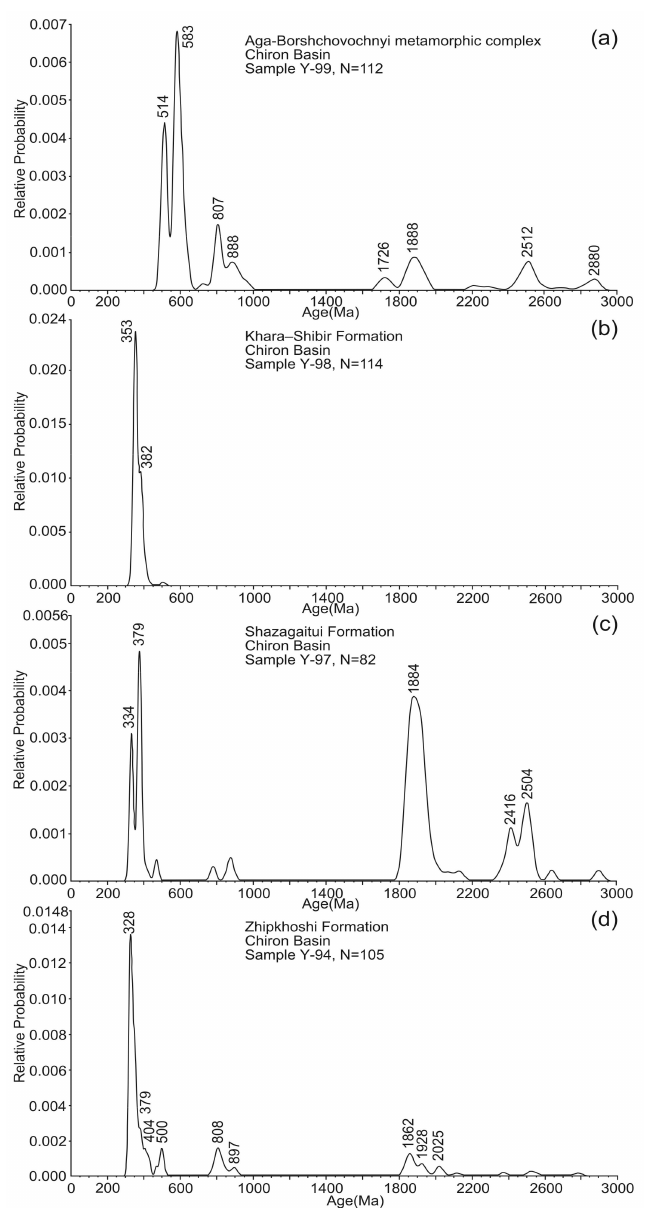
Figure 7. Probability diagrams showing age distributions of detrital zircons from Aga–Borshchovochnyi metamorphic complex and ciliciclastic rocks of the Chiron Basin. Data from Supplementary Table S2; ( a ) Aga-Borshchovochnyi metamorphic complex, ( b ) Khara-Shibir Formation, ( c ) Shazagaitui Formation, ( d ) Zhipkhoshi